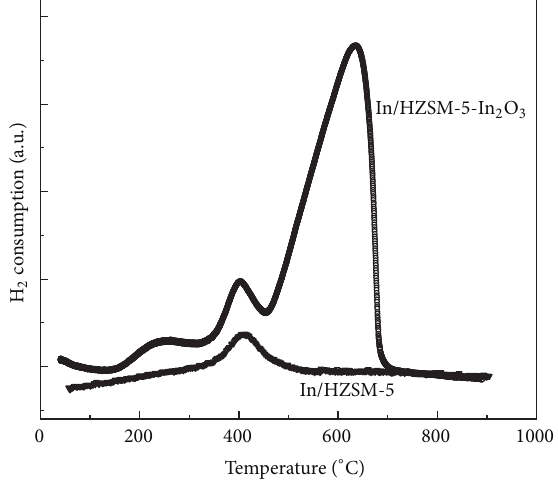
Figure 9: H 2 -TPR profiles over In/HZSM-5 (1:20) and In/HZSM- 5/In 2 O 3 (1:20 :5) catalysts with different ratios.